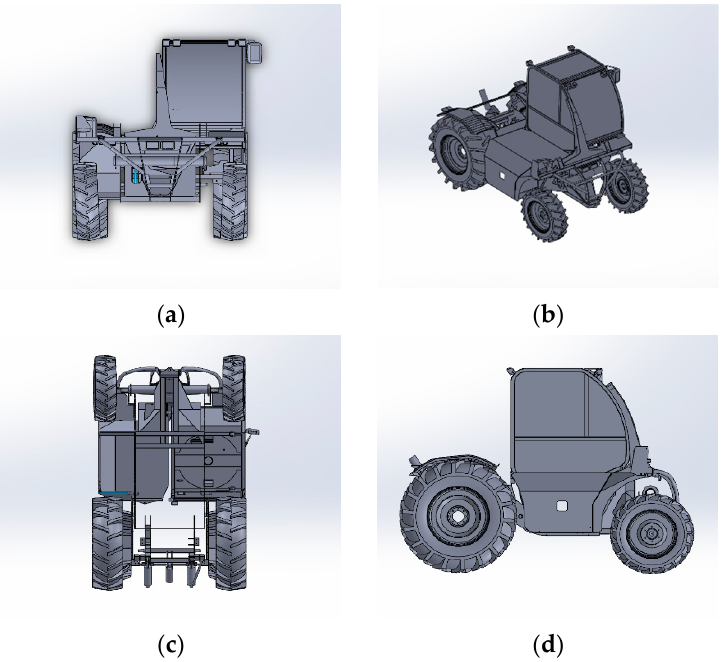
Figure 4. 3D model of the tractor used: ( a ) Front view; ( b ) Isometric view; ( c ) Bottom view; ( d ) Side view.